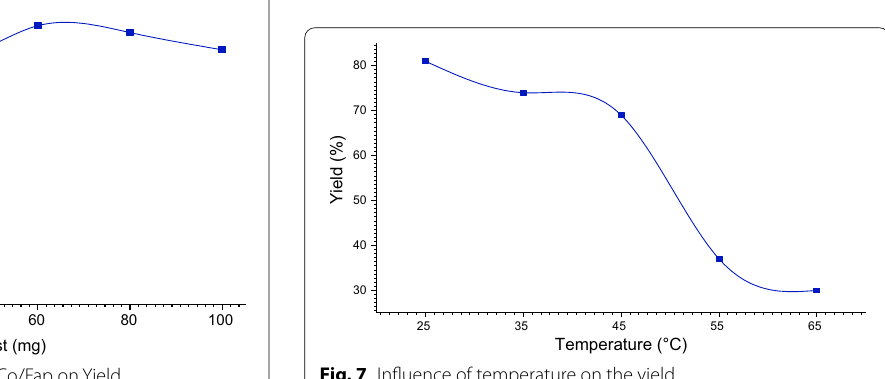
Fig. 5 Influence of the catalyst mass Co/Fap on Yield Fig. 7 Influence of temperature on the